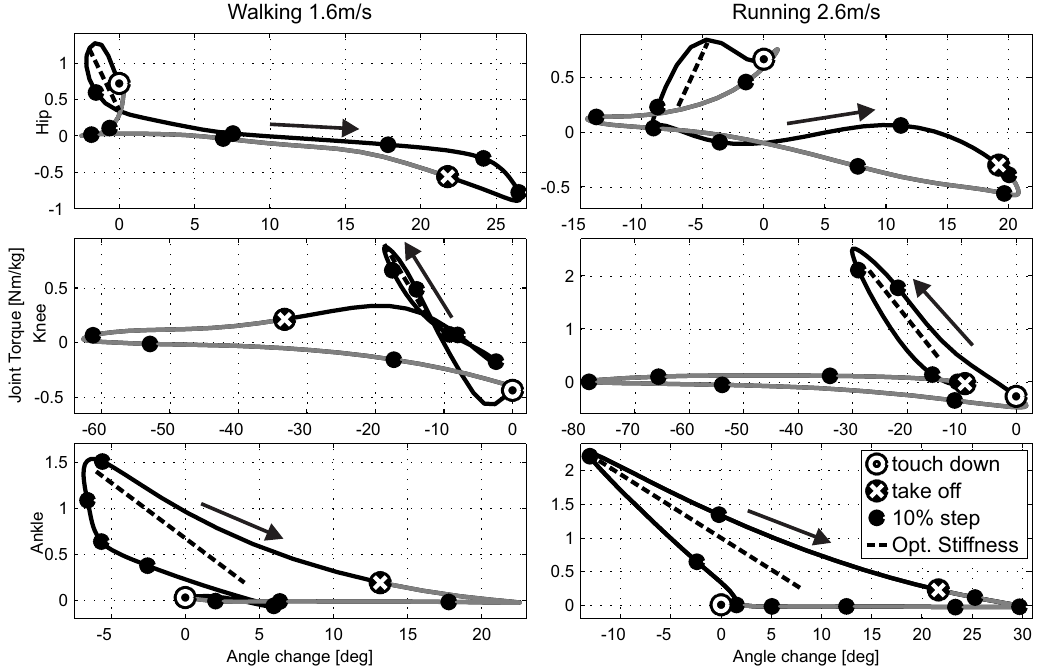
Figure 7. Hip, knee and ankle torque-angle curves for human walking at 1.6 m/s and running at 2.6 m/s (mean of all subjects). Arrows indicate the path direction during the gait cycle. The stance phase is shown in black, and the swing phase is shown in grey. Touch-down and take-off are indicated by a big dot. Small dots characterize time increments of 10% of the gait cycle starting at touch-down. The dashed line represents the slope of the optimal series stiffness listed in Table 2.